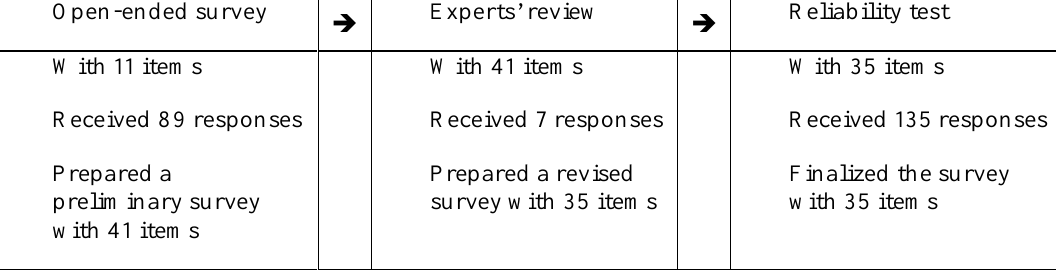
Figure 3 . Procedures in developing a survey